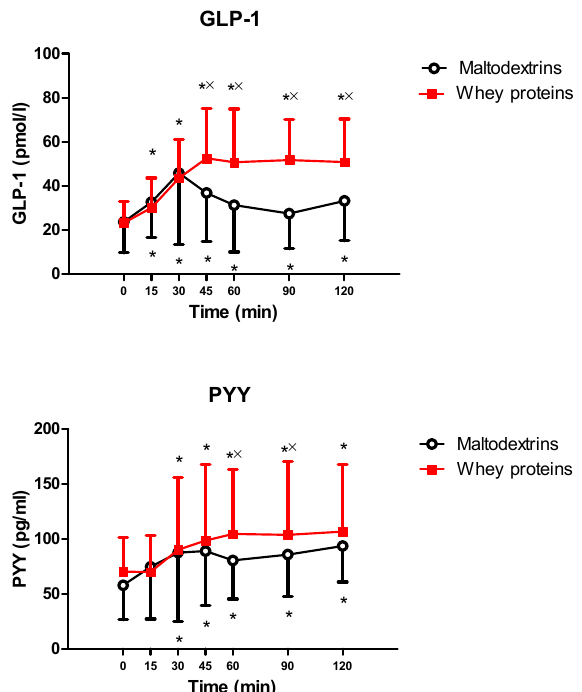
Figure 3. Changes of pancreatic polypeptide (PP) ( top ), glucagon-like peptide 1 (GLP-1) ( middle ), and peptide YY (PYY) ( bottom ) levels in young obese subjects after the intake of a drink (completely within 15 min starting at T0), containing whey proteins or maltodextrins. See the text for further details. Values are expressed as mean ± SD. The number of subjects was 9. * p < 0.05 vs. the corresponding T0 value; and × p < 0.05 vs. the corresponding value of the maltodextrins-treated group. A two-way ANOVA with repeated measures (with the two factors, time and group, and the interaction time × group), followed by the post hoc Tukey’s test, was used.